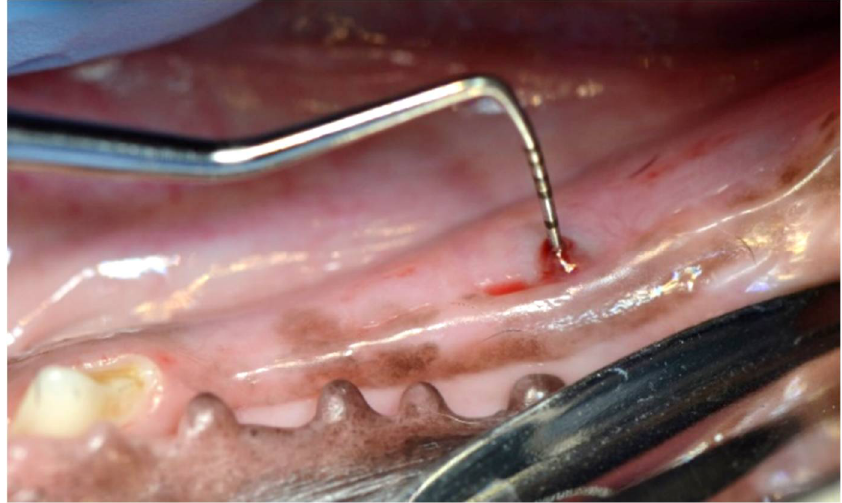
Figure 5. Oral implant communication can be detected with a periodontal probe, but the implant surface cannot be observed.